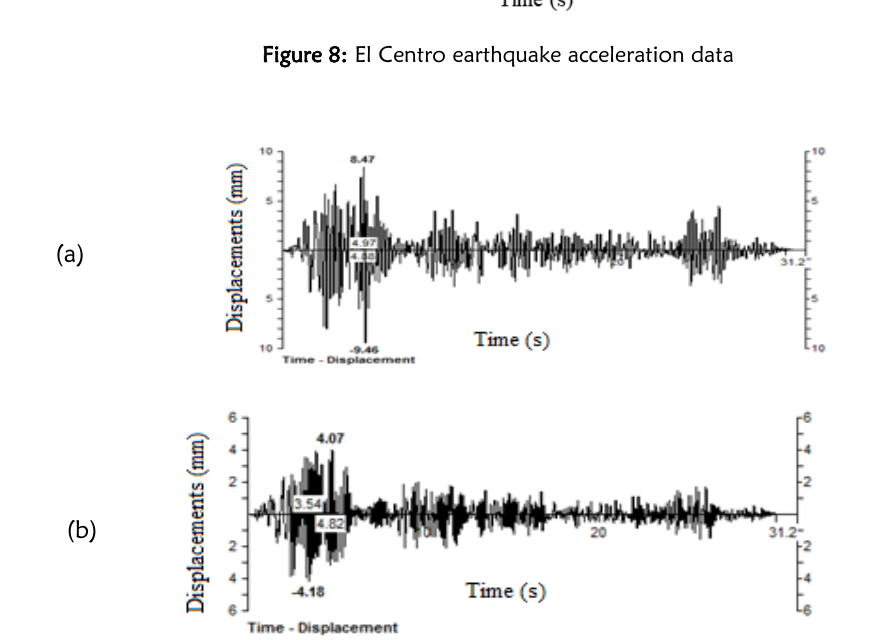
Figure 9 : Time-dependent peak-to-peak displacements along x - direction for single story ( a ) unreinforced (17.93 mm) and ( b ) reinforced (8.25 mm)